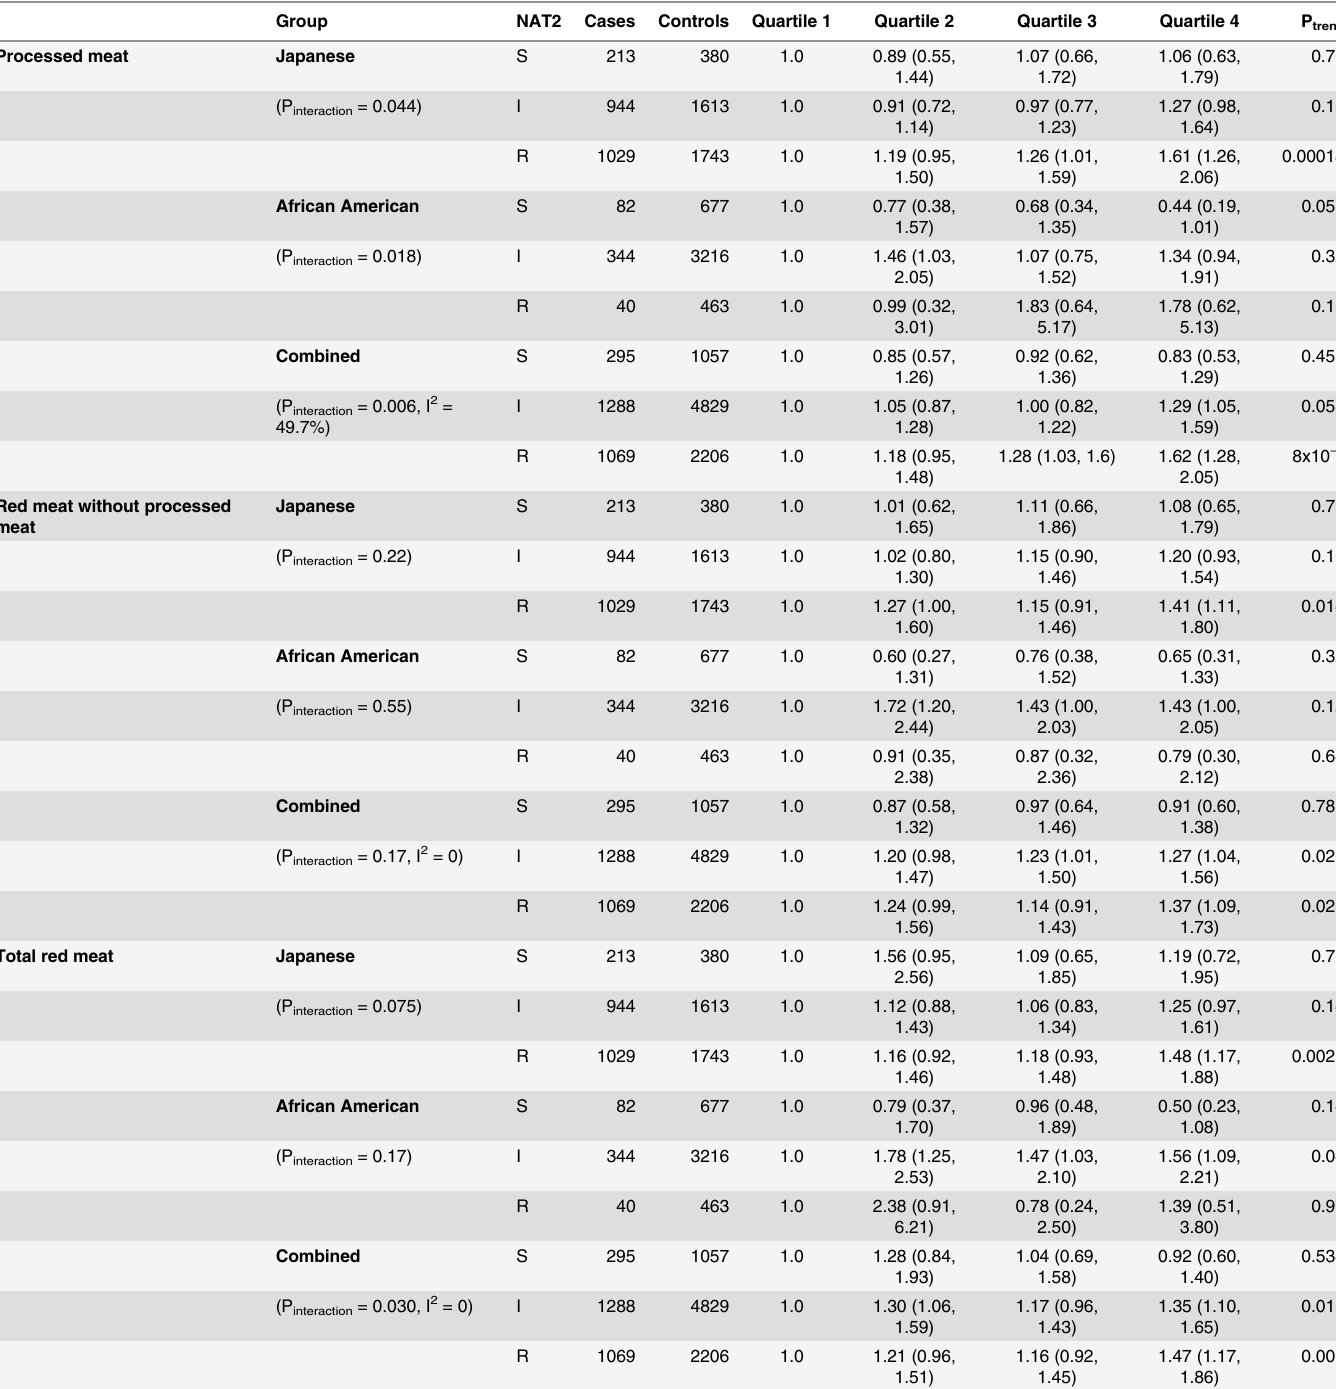
Table 3. Association of meat intake with colorectal cancer, stratified by NAT2